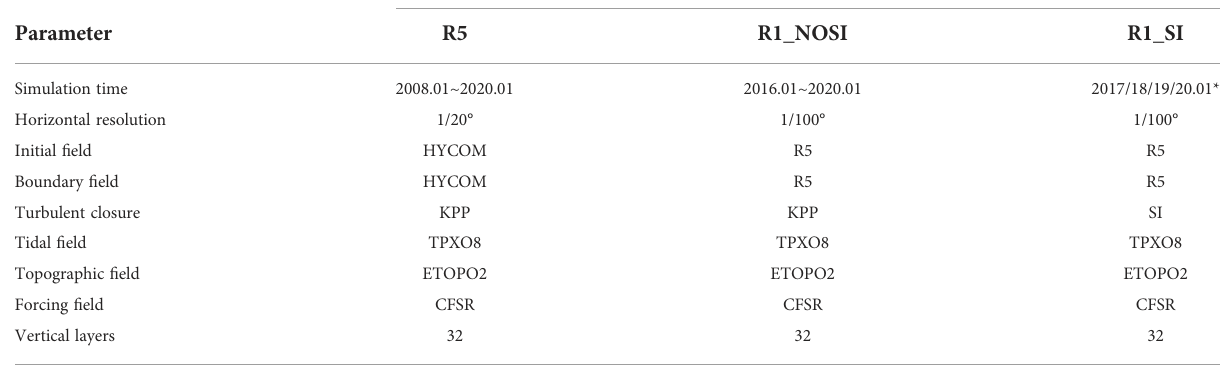
TABLE 1 Model con fi gurations of the different